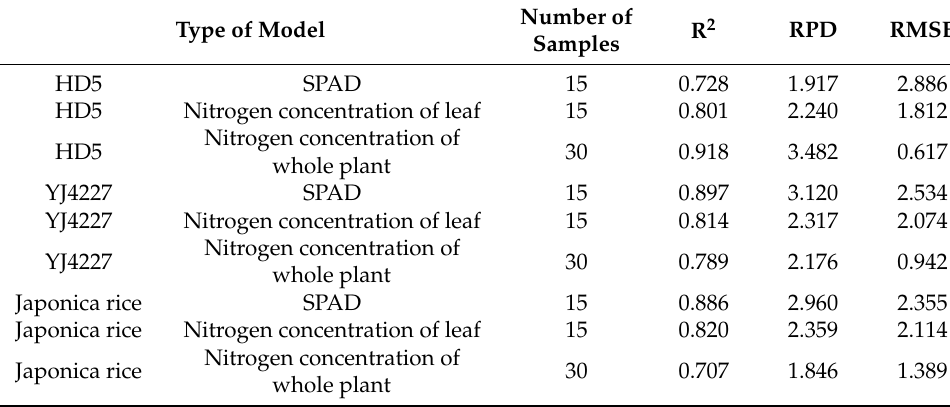
Table 12. The model’s